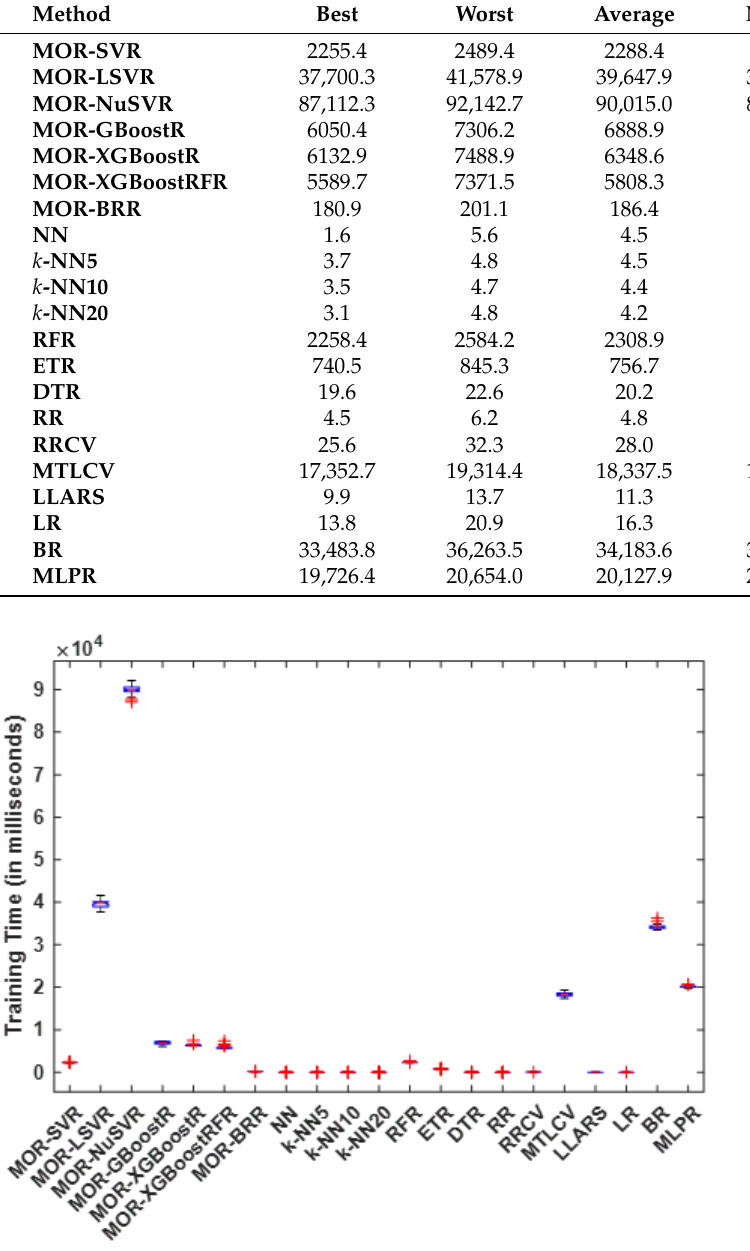
Figure 4. Box plots of TT (over 50 statistical runs) for all methods for the second